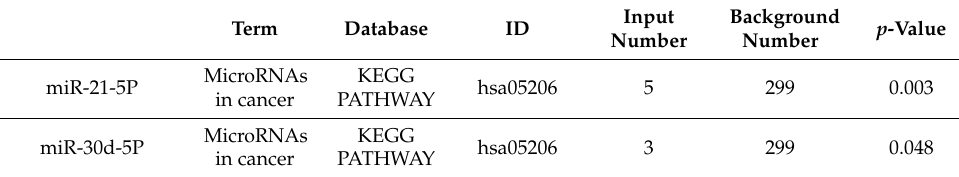
Table 4. KEGG pathway enrichment analysis of miRNAs performed using